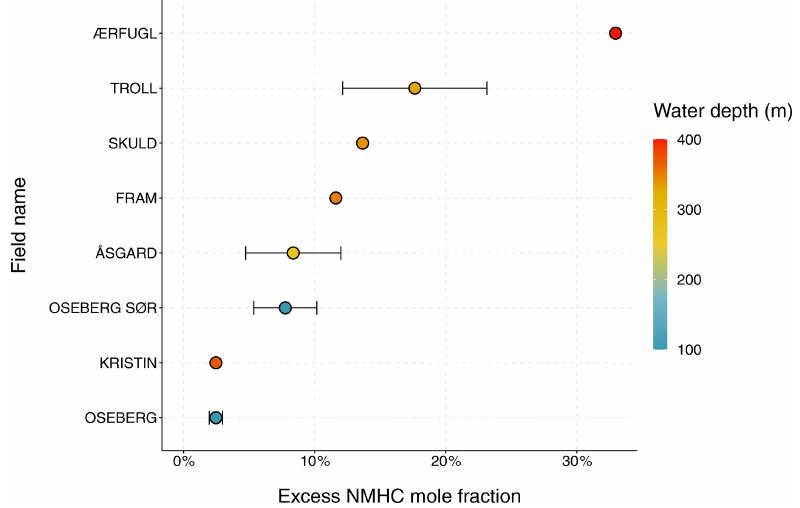
Figure A4. Mean excess mole fraction for individual offshore fields in the Norwegian sector of the North Sea coloured by water depth. Error bars represent 1 standard